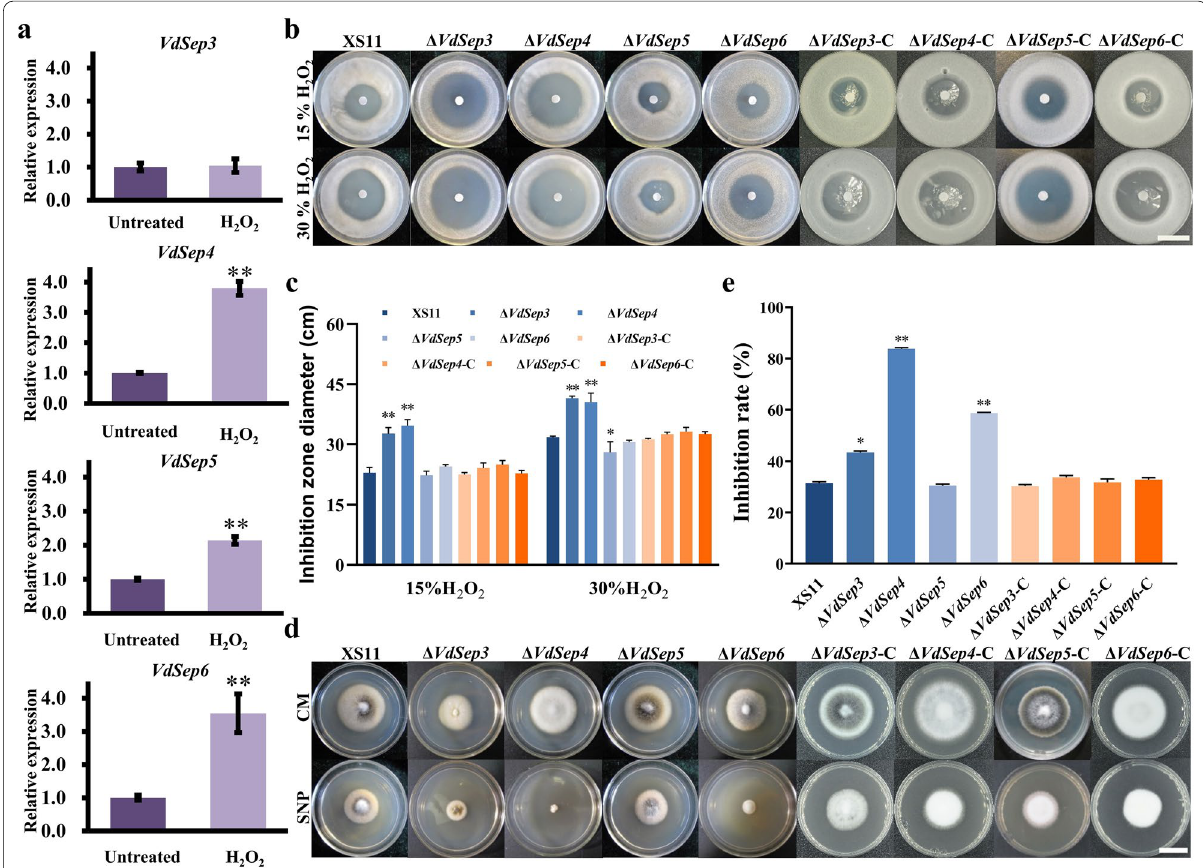
Fig. 6 The septin gene deletion mutants display distinct sensitivities to oxidative and nitrosative stress. a Reverse transcription-quantitative PCR analyses of the expression levels of the four septin genes VdSep3 , VdSep4 , VdSep5, and VdSep6 in XS11 in response to H 2 O 2 stress. Gene expression values were normalized against an endogenous control ( β-tubulin gene). Error bars represent standard deviation based on three independent replicates (**, P < 0.01). b Colony growth assay under stress by 15% H 2 O 2 (upper panel) or 30% H 2 O 2 (lower panel). Conidial suspension of each indicated strain was mixed with melted potato dextrose agar (PDA) medium to a final concentration of 10 7 conidia/mL and poured into a petri dish to prepare plates. A sterile filter paper disk (5 mm in diameter) was transferred to the center of the plate and 5 μL H 2 O 2 (15% or 30%) was then added to each paper disc. The diameters of the inhibition zone were measured after incubation at 25 °C for 3 days. Bar 2 cm. c Statistic analysis of = growth inhibition in b. Error bars represent standard deviation based on three independent replicates (**, P < 0.01; *, P < 0.05). d Colony growth assay in the presence of sodium nitroprusside dehydrate (SNP, 10 mM). All the strains were grown on complete medium (CM) or CM containing 10 mM SNP for 10 days. Bar 2 cm. e Statistical analysis of growth inhibition in d . Error bars represent standard deviation based on three independent = replicates (**, P < 0.01; *, P <